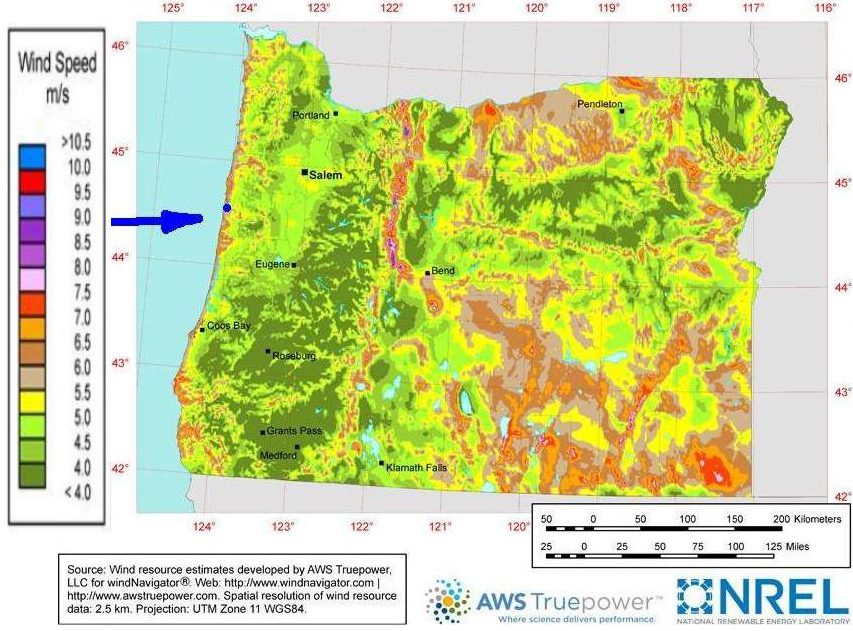
Figure 14. Average annual wind speed of Oregon at 80 m.